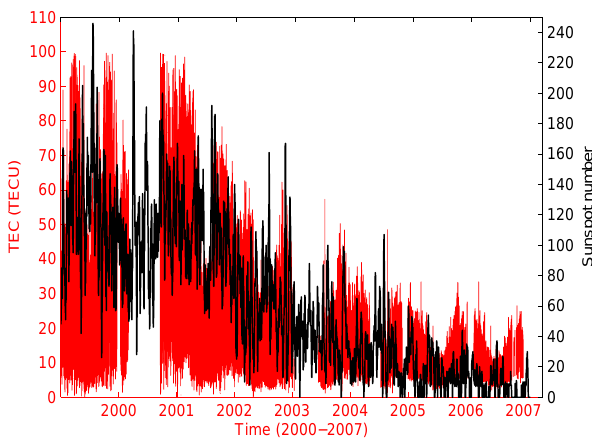
Fig. 5. Hourly GPS TEC data over SUTH (2000–2007) used for NN training along with daily sunspot